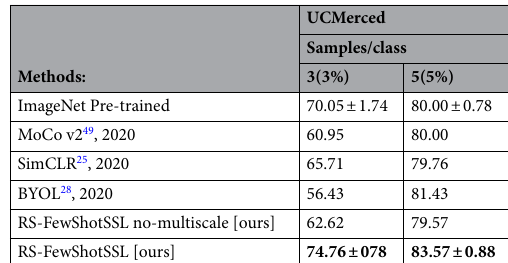
Table 3. RS-FewShotSSL results for the UCMerced dataset and comparison to state-of-the-art methods. Significant values are in bold.